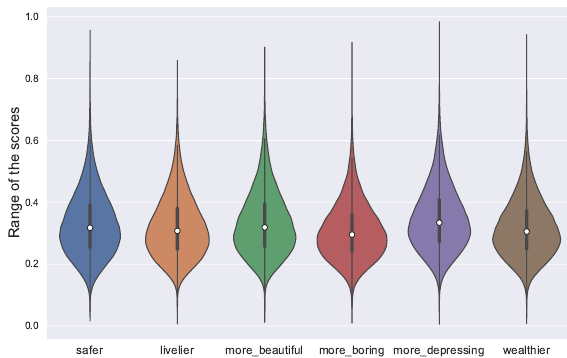
Figure 4. Top view of a panorama with the ticks representing the heading azimuths. Lines of the same color represent the four Figure 3. Distributions of the range of the thirty-six scores of camera directions for the four perspective images in a 4-split. each panorama, for each quality. The red 4-split corresponds to the black one shifted by 20°, and the blue one is equal to the red one shifted by 20°.